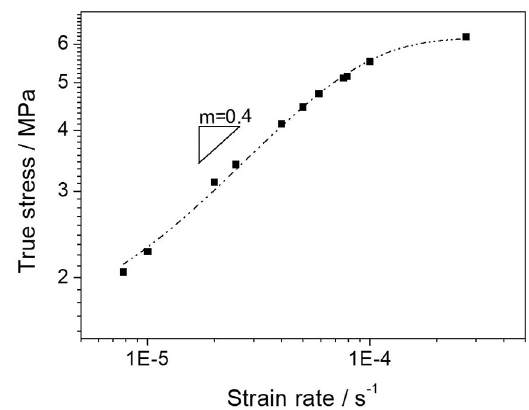
Figure 6. True stress vs. strain rate at 570ºC of the AA5083-O, the data were extracted from Table